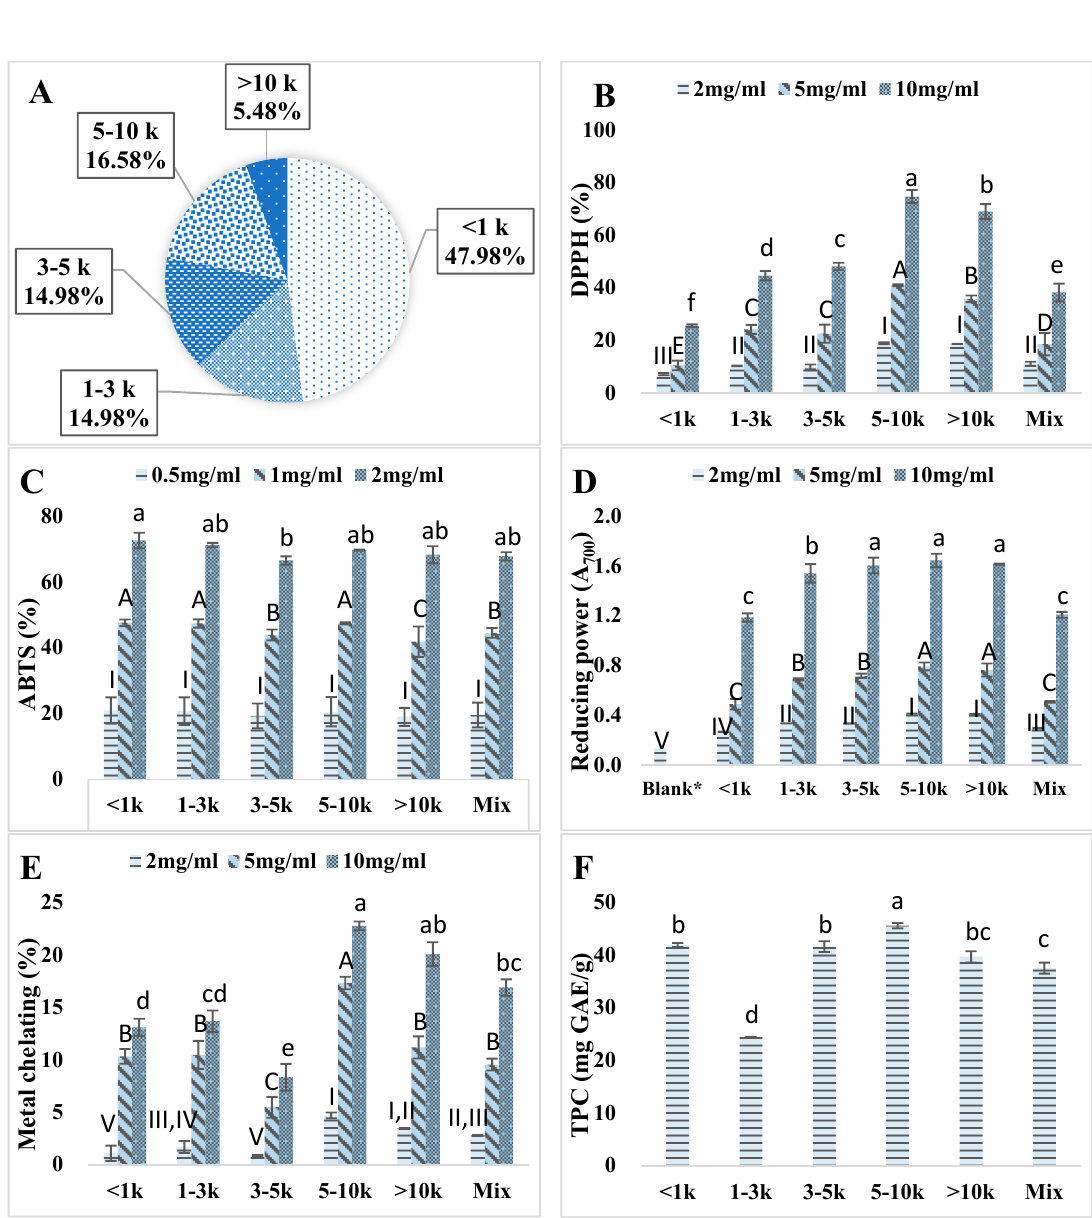
Figure 2. Ultrafiltration of kafirin Alcalase hydrolysates prepared at enzyme-to-substrate ratio of 0.4 Au / g and hydrolyzed for 4 h followed with MWCO membrane filtration at 10 k, 5 k, 3 k, and 1 kDa. ( A ). Weight distribution; ( B ). DPPH scavenging activity (%); ( C ). ABTS scavenging activity (%); ( D ). Reducing power capacity (Abs at 700 nm); ( E ). Metal chelating capacity (%); ( F ). Total phenolic content (mg GAE / g). * Blank represents the absorbance of reaction mixture at 700 nm using distilled water in substitute of sample. Di ff erent lowercase letters, capital letters, and roman numerals indicated significant di ff erence at p <